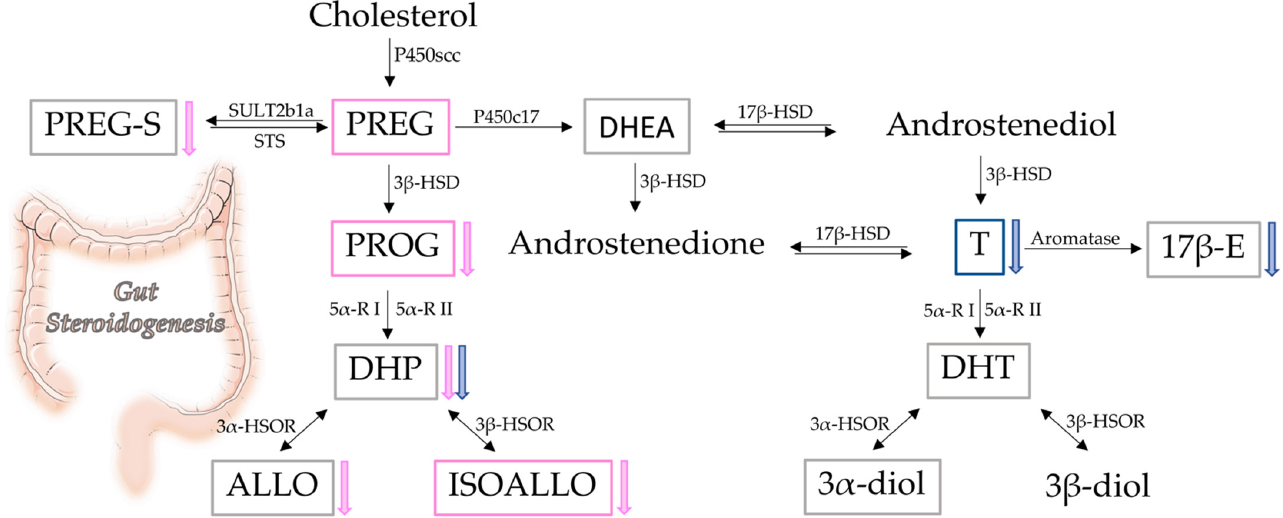
Figure 8. Schematic representation of gut steroidogenesis. Framed steroids reported have been assessed by LC-MS/MS. Pink frame: higher levels in intact female; blue frame: higher levels in intact male; grey frame: no sex difference. Arrows represent the effect of gonadectomy in female (pink) and in male (blue).